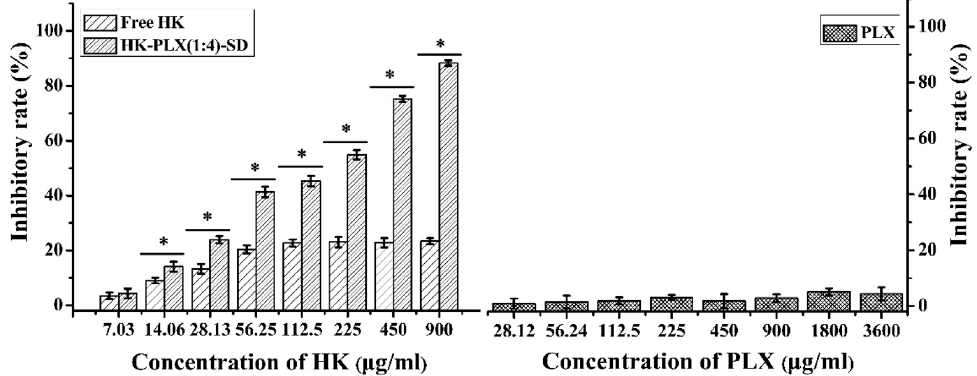
Figure 10. Inhibitory rate of the free HK, the HK–PLX (1:4) SD, and the corresponding PLX (* p <